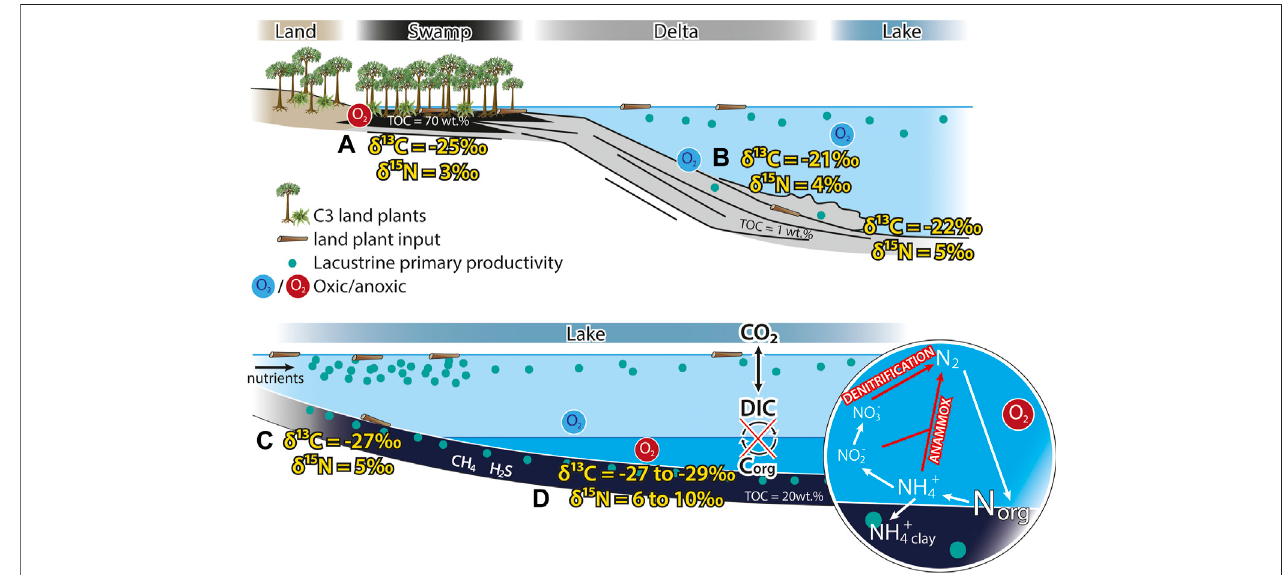
FIGURE 13 | Synthetic sketch showing the different ways to obtain TOC, δ 13 C org and δ 15 N bulk values depending on depositional environments and lake water physicandchemicalparameters. (A) SwampenvironmentmaterializedbyadominantTypeIIIOMconstitutingthecoaldeposits,withmoderate δ 13 C org and δ 15 N bulk . (B) Deltaic to lacustrine environment dominated by terrigenous land plants inputs, displaying high δ 13 C org (depending on the mixing of the two OM) and low δ 15 N bulk values. (C) Shallow lake environment (littoral lake) dominated by lacustrine OM with some terrigenous land plant inputs, marked by very low δ 13 C org and δ 15 N bulk values, indicating anoxic sediments but the absence of a developed chemocline. The low water column prevents the oxidation of OM during sinking. (D) Deep lacustrine environment with a well-developed chemocline, leading to anoxia in bottom waters and sediments, favouring the lacustrine OM preservation, and the denitri fi cation and anammox